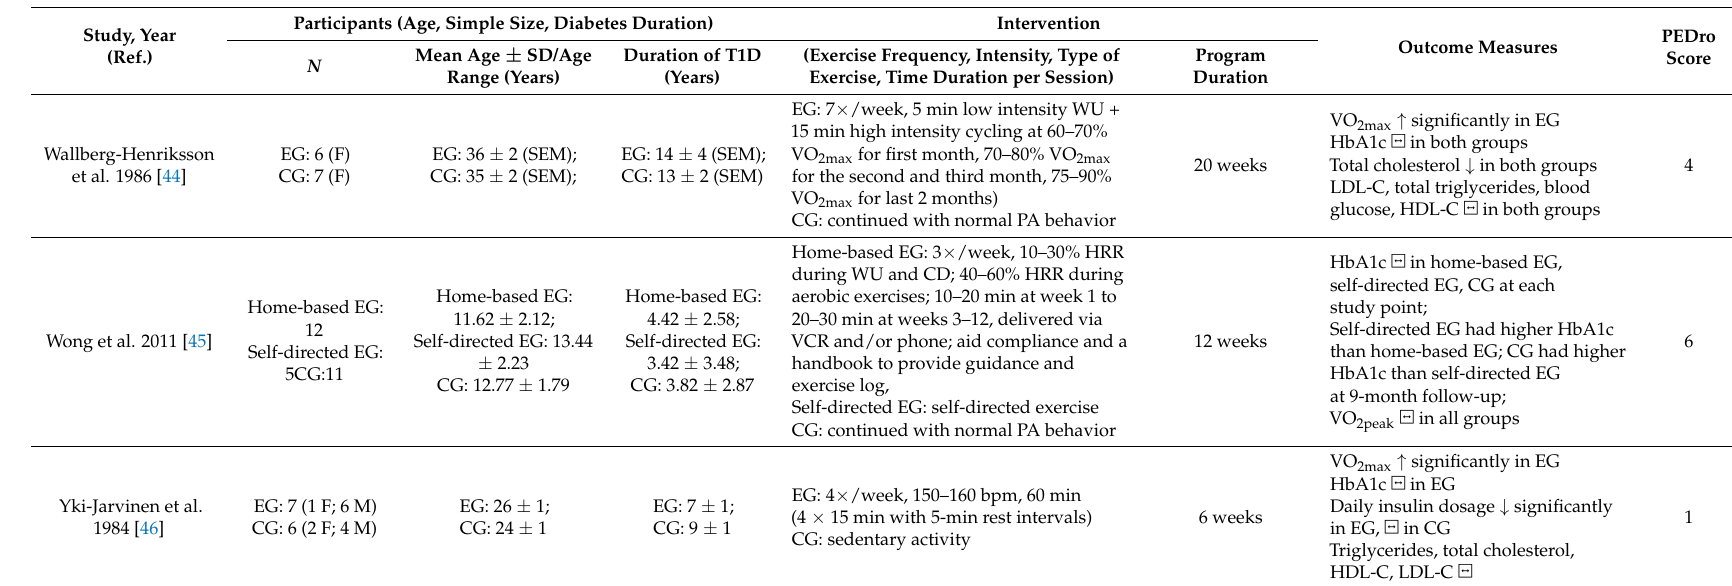
Table 1. Characteristics of the included